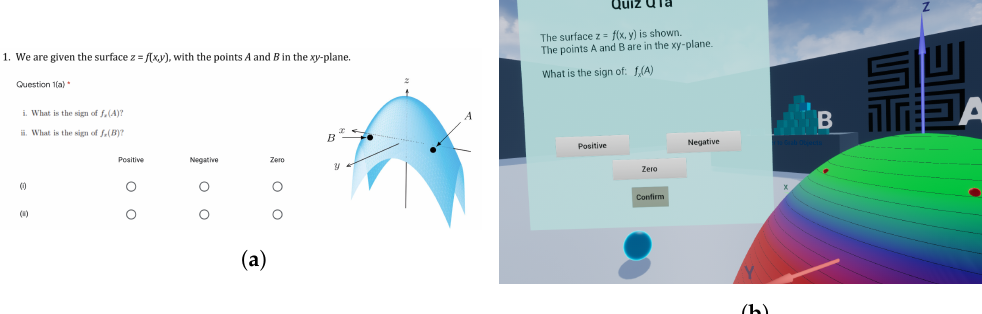
Figure 5. A comparison between the delivery of question 1 in the ( a ) baseline test and ( b ) treatment